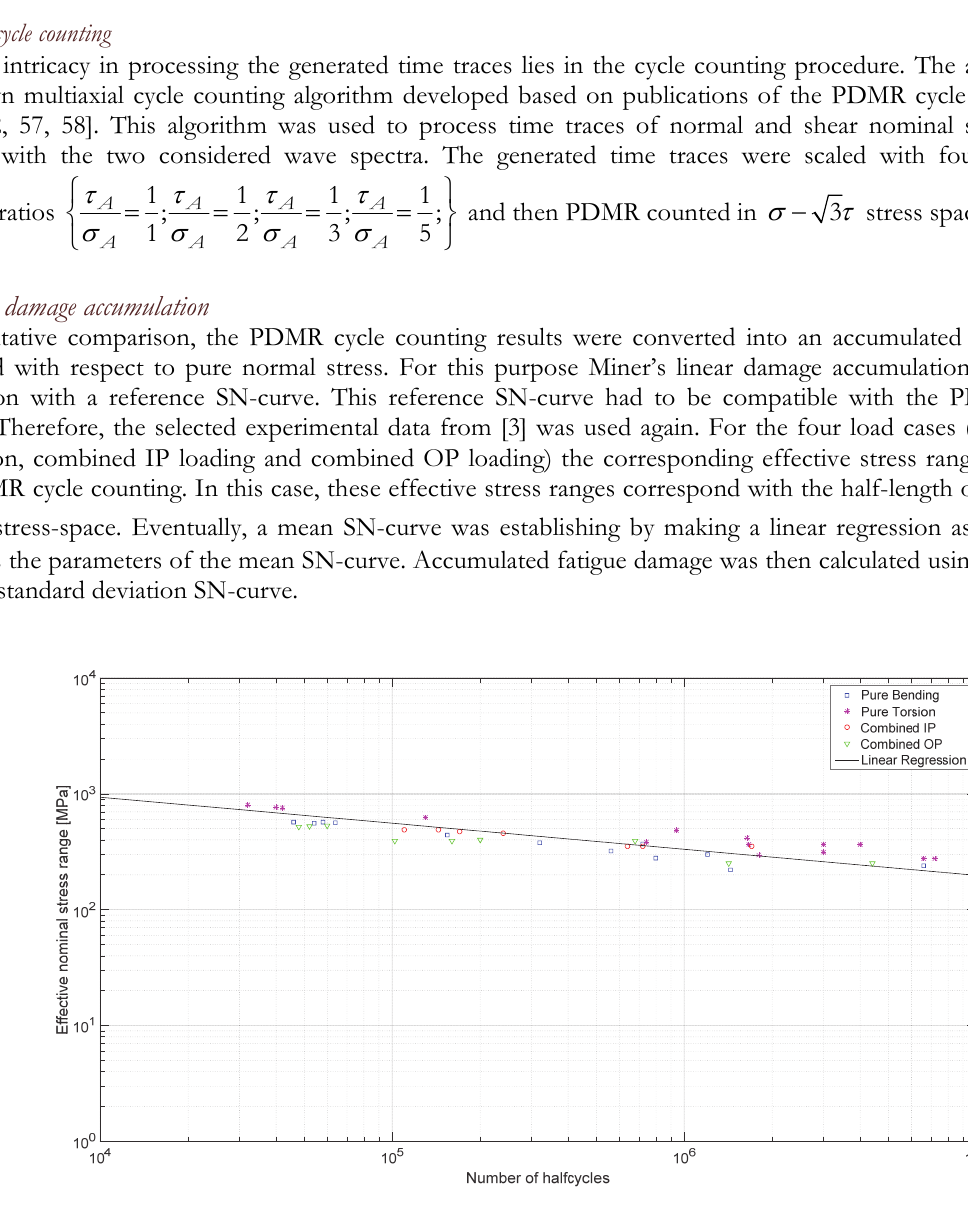
Figure 8: Mean SN-curve used to determine the accumulated fatigue data and generated using data published in